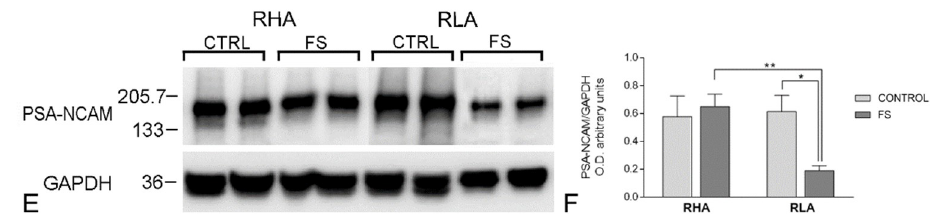
Figure 3. Western blot analysis of the BDNF ( A , B ), trkB ( C , D ), and the PSA-NCAM ( E , F ), in the ventral hippocampus of the RHA and the RLA rats, under the baseline conditions (CONTROL), and after forced swimming (FS). ( A , C , E ): BDNF-immunostained blots ( A ), trkB-immunostained blots ( C ), and PSA-NCAM-immunostained blots ( E ) showing representative samples from two rats; ( B , D , F ): Densitometric analysis of the BDNF/GAPDH ( B ), trkB/GAPDH ( D ), and the PSA-NCAM/GAPDH band gray optical density (O.D.) ratios ( F ). The columns and bars denote the mean ± S.E.M. of eight rats, in each experimental group. *: p < 0.05; **: p < 0.01 (Tukey’s post hoc test or Sidak’s correction, for multiple comparisons).